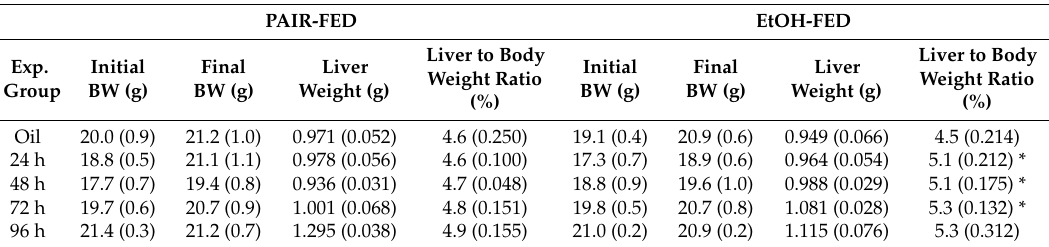
Table 1. Initial and final body weights, liver weights and liver to body weight